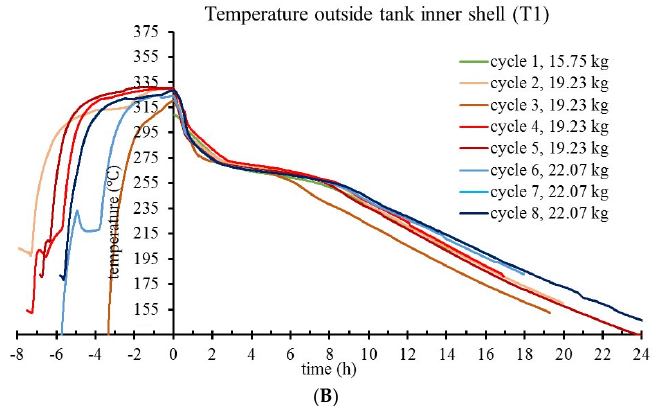
Figure 6. T4 ( A ) and T1 ( B ) temperature evolution during charge–self-discharge cycles of the prototype tank, for progressively increased loads of storage material. In the evaluation of the thermal energy storage capacity of the tank, two loads of microcapsules were considered: 19.23 and 22.07 kg. T4 monitors the solidification in the innermost spot of the tank, therefore informative for the end of the latent heat release phase. At high temperature change rates, T4 readings are affected by nonequilibrium, with measured temperature differences up to 15 °C for the interval of interest. Thus, to protrude with the T3–T5 thermocouples at their deep spots into the storage material, the tank has three thin tubes welded on the longitudinal side. The tubes are closed at the pro- truding end and they prevent direct contact between thermocouples and microcapsules.